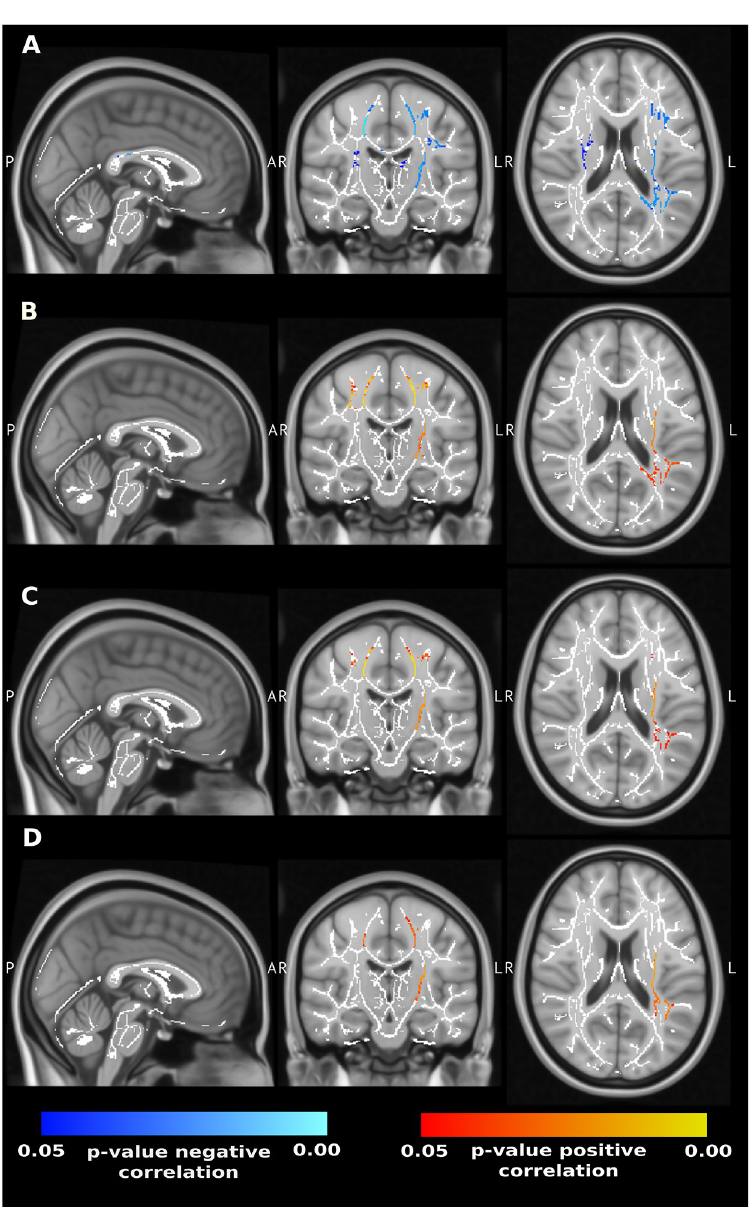
Fig 3. The results of TBSS for fractional anisotropy (FA). Blue colour scale signifies negative correlation between FA and the clinical variable, red colour scale stands for positive correlation (either positive or negative correlation is depicted per clinical scale). A: Negative correlation of FA and age. B: Positive correlation between FA and executive functions. C: Positive correlation between FA and attention. D: Positive correlation between FA and memory. Note that the correlations shown in B , C , C , did not persist (as statistically significant) after controlling for age, that was indeed detected as a significant analysis confound, see A